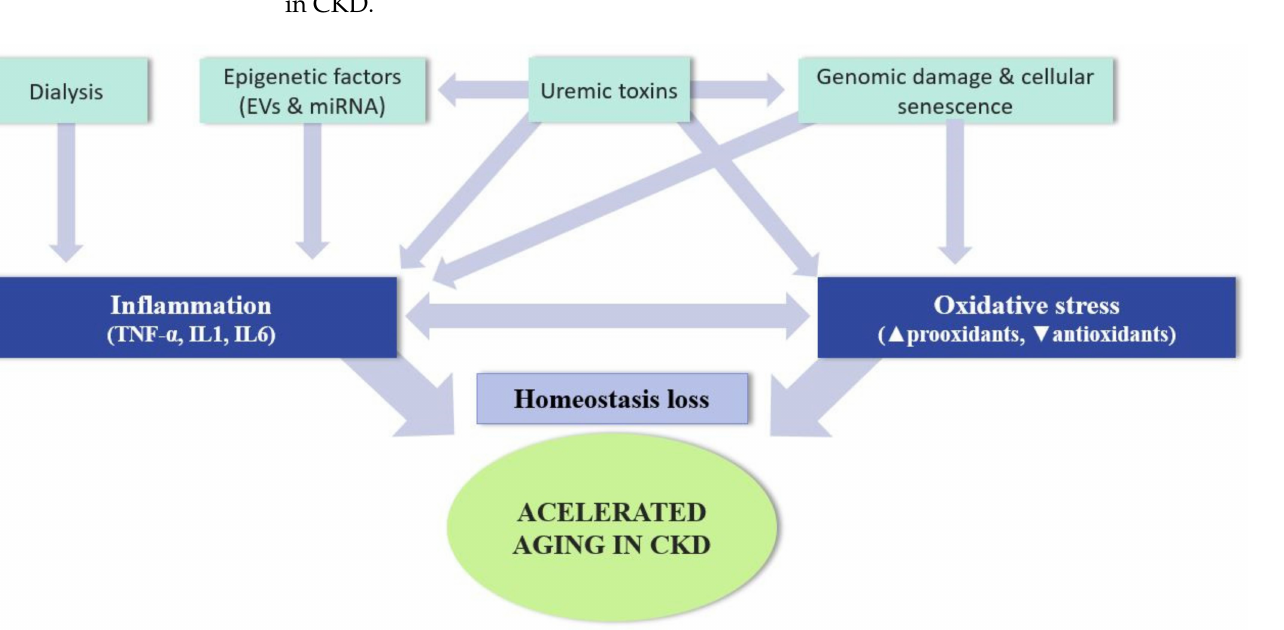
Figure 3. Causes of accelerated aging in patients with chronic kidney